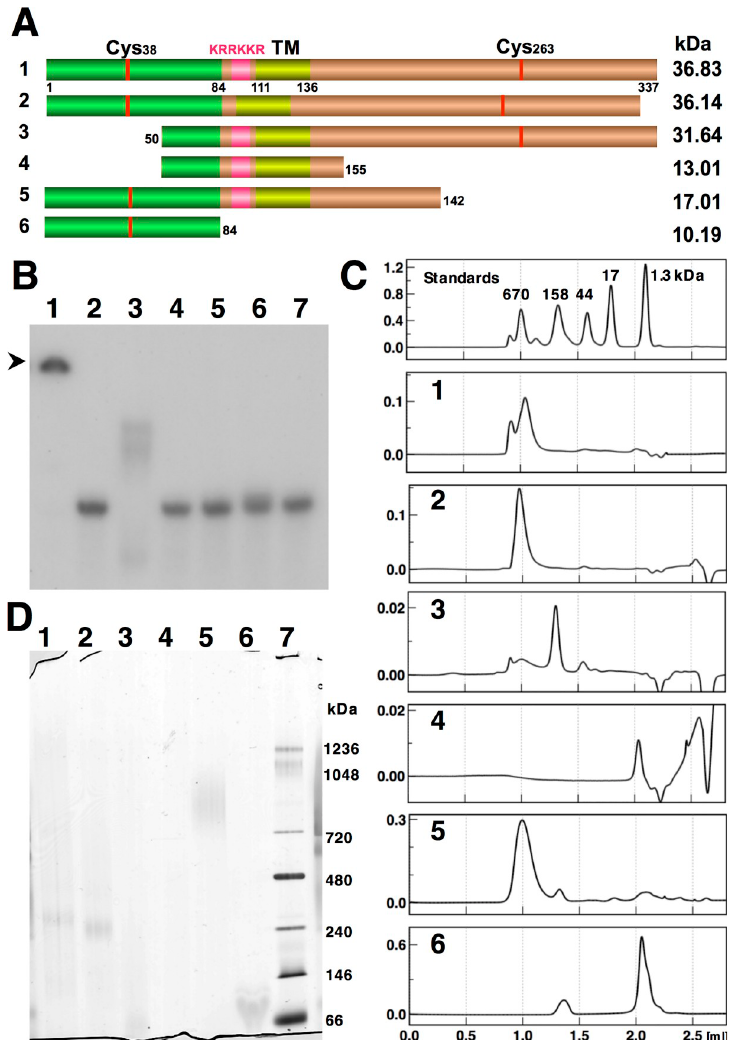
Fig 2. Functional mapping of the RNA-binding domain and multimerization of RodZ. The numbers indicating the RodZ variants are as follows: 1, RodZ wt ; 2, RodZ Δ KRRKKR ; 3, RodZ 50-337 ; 4, RodZ 50-155 ; 5, RodZ 1-142 ; 6, RodZ 1-84 . (A) RodZ domains and deletion constructs: green, cytosolic; pink, KRRKKR; yellow, transmembrane; ocher, periplasmic domain; red, cysteine residues. Calculated molecular weights of the -his 6 fusion proteins are indicated on the right side of the panel. (B) RNA binding activities of the indicated deletion proteins determined using EMS analysis. Lane 7: RNA probe without protein. Arrowhead indicates bottom of gell wells. (C) Gel filtration analysis of the deletion proteins. Standards: Elution profile of the molecular-weight standards is identical to that shown in Fig 1A. (D) BN-PAGE analysis of the deletion proteins. Lane 7: Molecular mass markers.